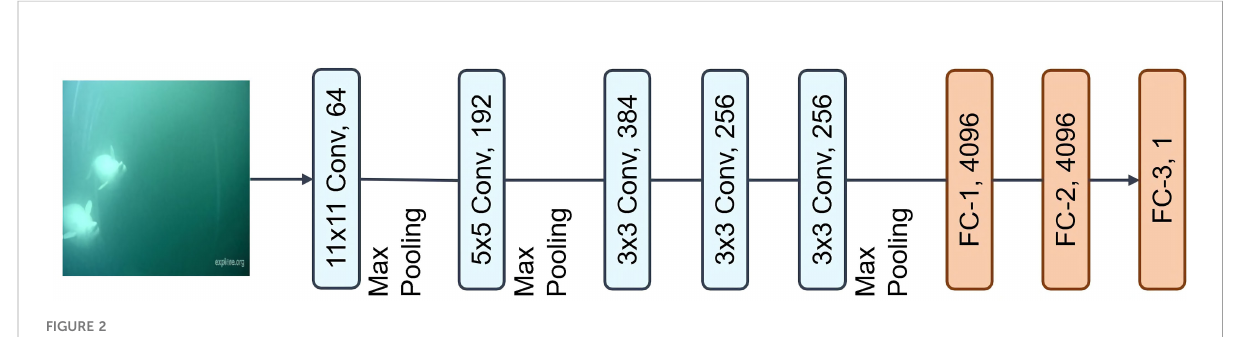
FIGURE 2 Schematic of the AlexNet convolutional neural network